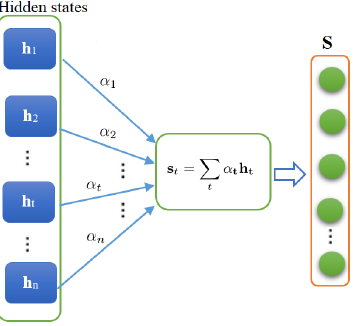
Figure 1. Schematic representation of attention